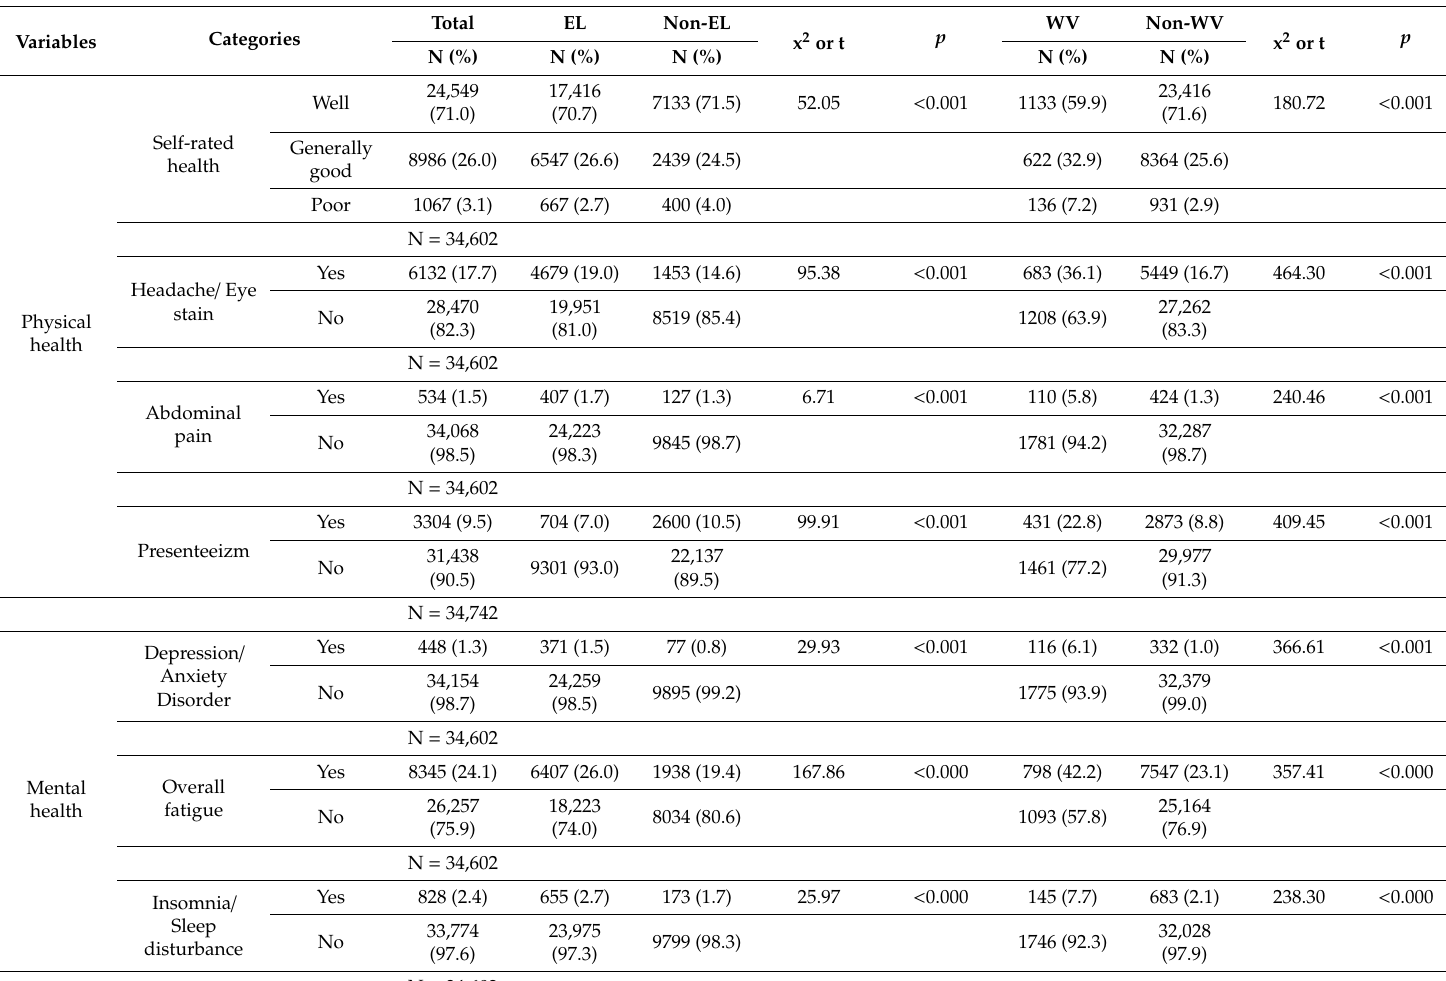
Table 3. Di ff erence in physical and mental health outcomes according to emotional labor and workplace